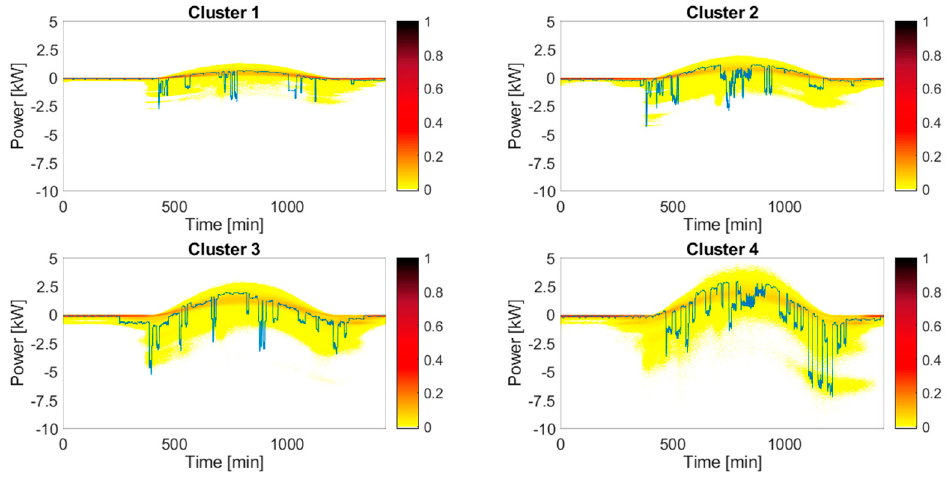
Figure 10. 2D clustering: profiles in time domain grouped by cluster and their respective centroids.